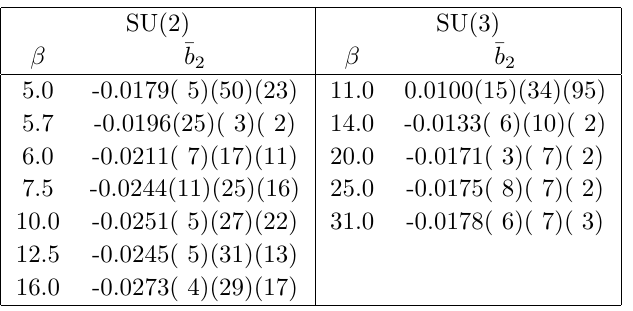
Table 7 . Final results for (cid:22) b 2 for the individual lattice spacings. The (cid:12)rst error is the statistical uncertainty, the second the systematic one due to the unknown correction terms, estimated by calculating the maximal deviations of the results for (cid:22) b 2 from (cid:12)ts B to C , and the third is the systematic one associated with the choice for R min